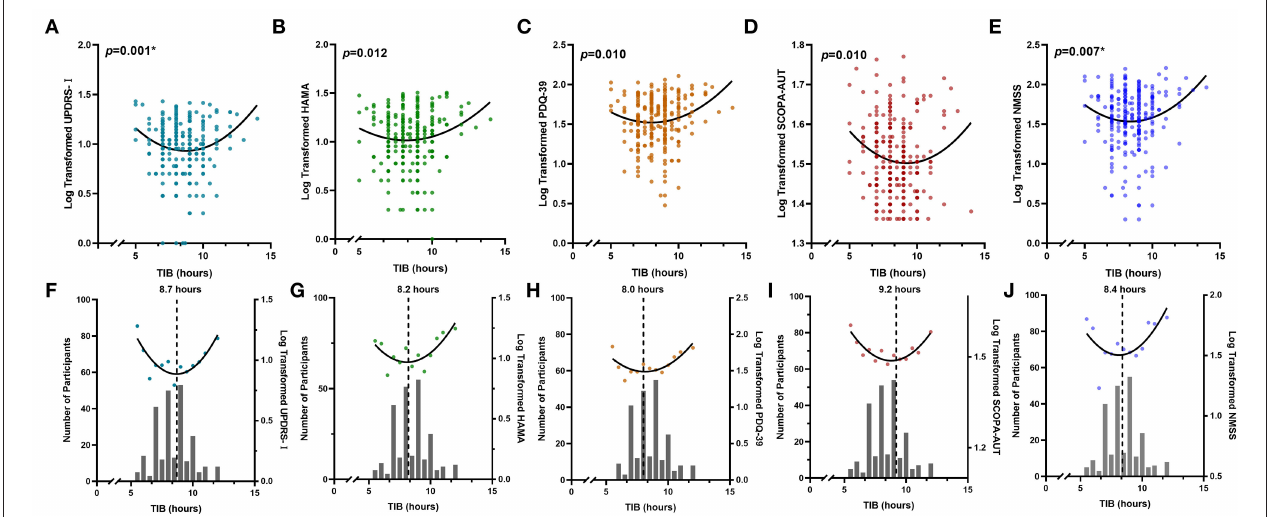
FIGURE 2 | Non-linear associations between sleep habits and PD symptoms. Total time spent in bed showed reverse U-shaped associations with different NMSs, including UPDRS-I (A,F) , HAMA (B,G) , PDQ-39 (C,H) , SCOPA-AUT (D,I) , and NMSS (E,J) . Either insufficient or excessive TIB is associated with worse performances of NMSs. The numbers of individuals with each sleep hour are shown in the bar graph. * The p -value was survived after Bonferroni correction ( p < 0.008). HAMA , Hamilton Anxiety Rating Scale; MDS-UPDRS , Movement Disorder Society Unified Parkinson’s Disease Rating Scale; NMSS , Non-Motor Symptoms Scales; PDQ-39 , 39-item Parkinson’s Disease Questionnaire; SCOPA-AUT , Scale for Outcomes in PD for Autonomic Symptoms; TIB , total time spent in